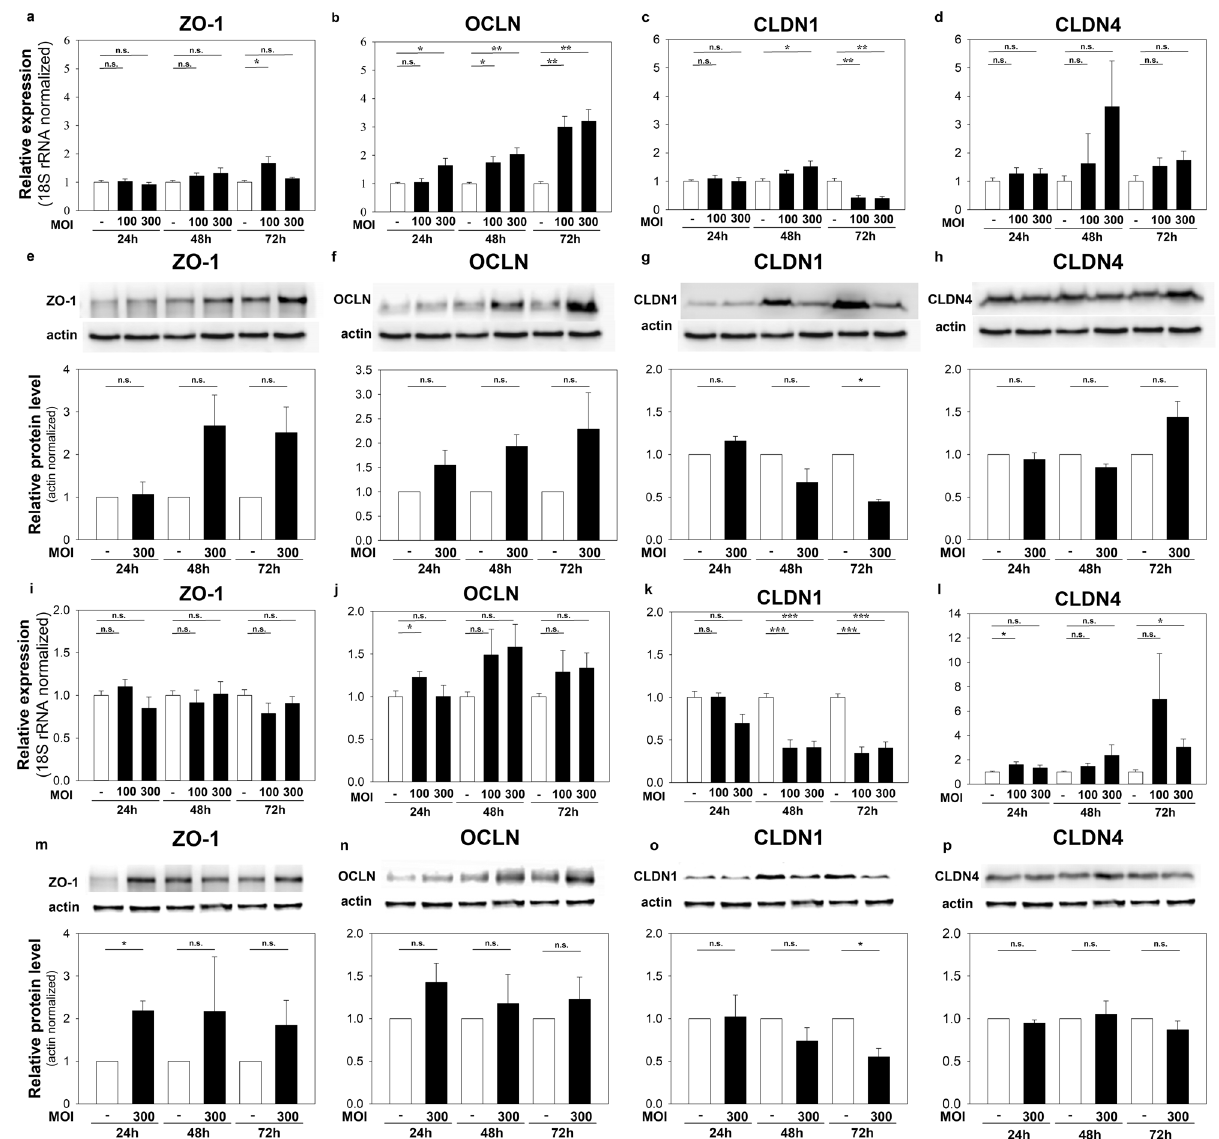
Figure 4. mRNA- and protein-expression changes of selected TJ proteins in Ca-low ( a – h ) and Ca-high ( i – p ) HPV-KER monolayer cultures co-cultured with C. acnes 889 strain. ZO-1 ( a , e , i , m ), OCLN ( b , f , j , n ), CLDN1 ( c , g , k , o ) and CLDN4 ( d , h , I , p ) mRNA and protein expression changes were monitored by real-time RT-PCR and western blot analysis. For detailed explanation, see the corresponding text. (mRNA data corresponds to the average of three parallel experiments, where each treatment was performed in three replicates. Western blot data shows a representative experiment. Detailed description can be find in Supplementary Figs. 6 and 7. Data points represents the average ± SEM. Statistical analysis with Student’s t-test, not significant (n.s.), *p < 0.05, **p < 0.005, ***p < 0.00005. The representative western blot and the graph corresponds to the average of three independent